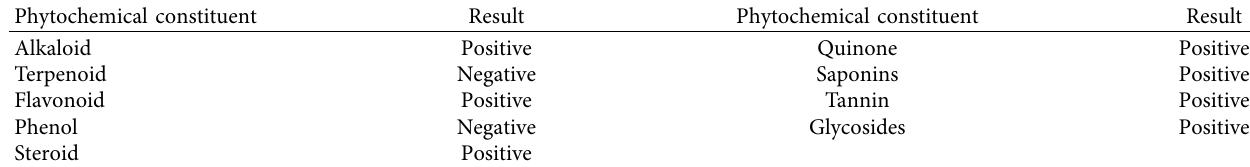
Table 2: The result of preliminary phytochemical screening of the hydro-methanolic extract of the EVCE. Phytochemical